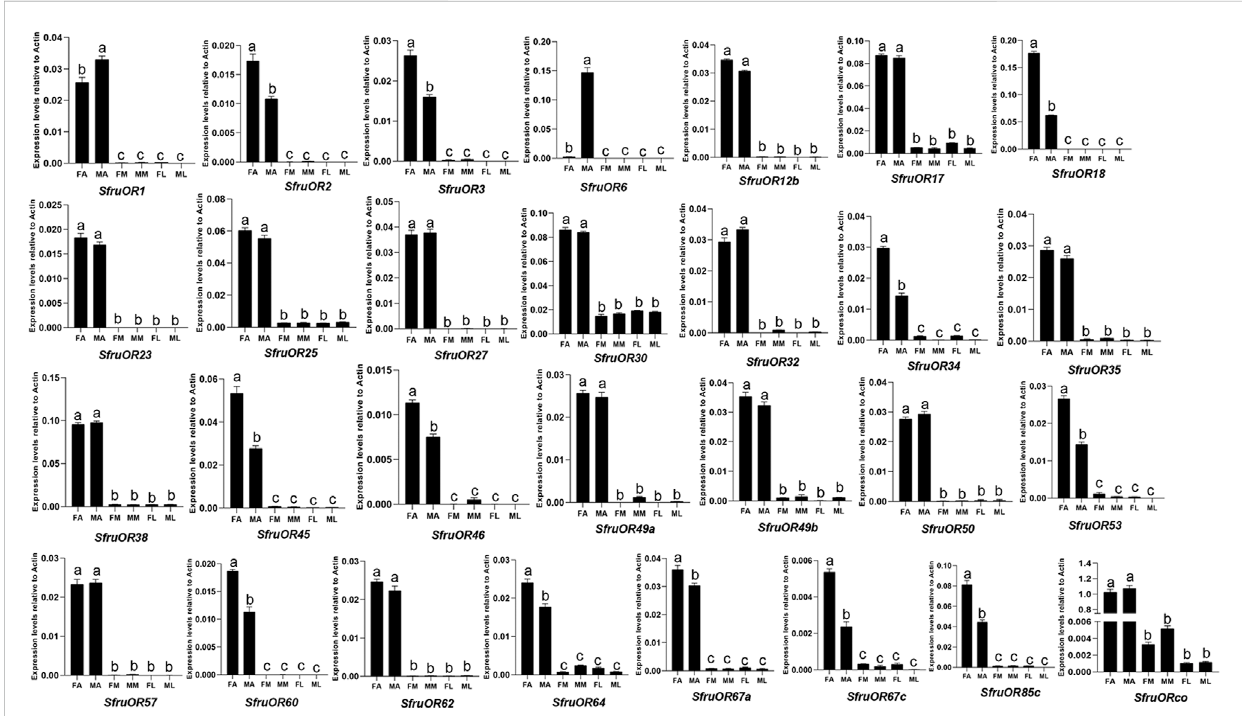
FIGURE 5 Expression patternsofcandidate ORs indifferentchemosensorytissuesofadult S.frugiperda .RT-qPCRanalysiswasconducted for SfruOR genesin femaleantennae(FA),male antennae(MA),femalemouthparts(FM),male mouthparts (MM),femalelegs (FL), andmale legs(ML).Different letters indicate signi fi cant difference based on a one-way ANOVA followedby Tukey ’ smultiple comparison test. Error bars show the standard errors of the means (+SE), p < 0.05, n = 3.